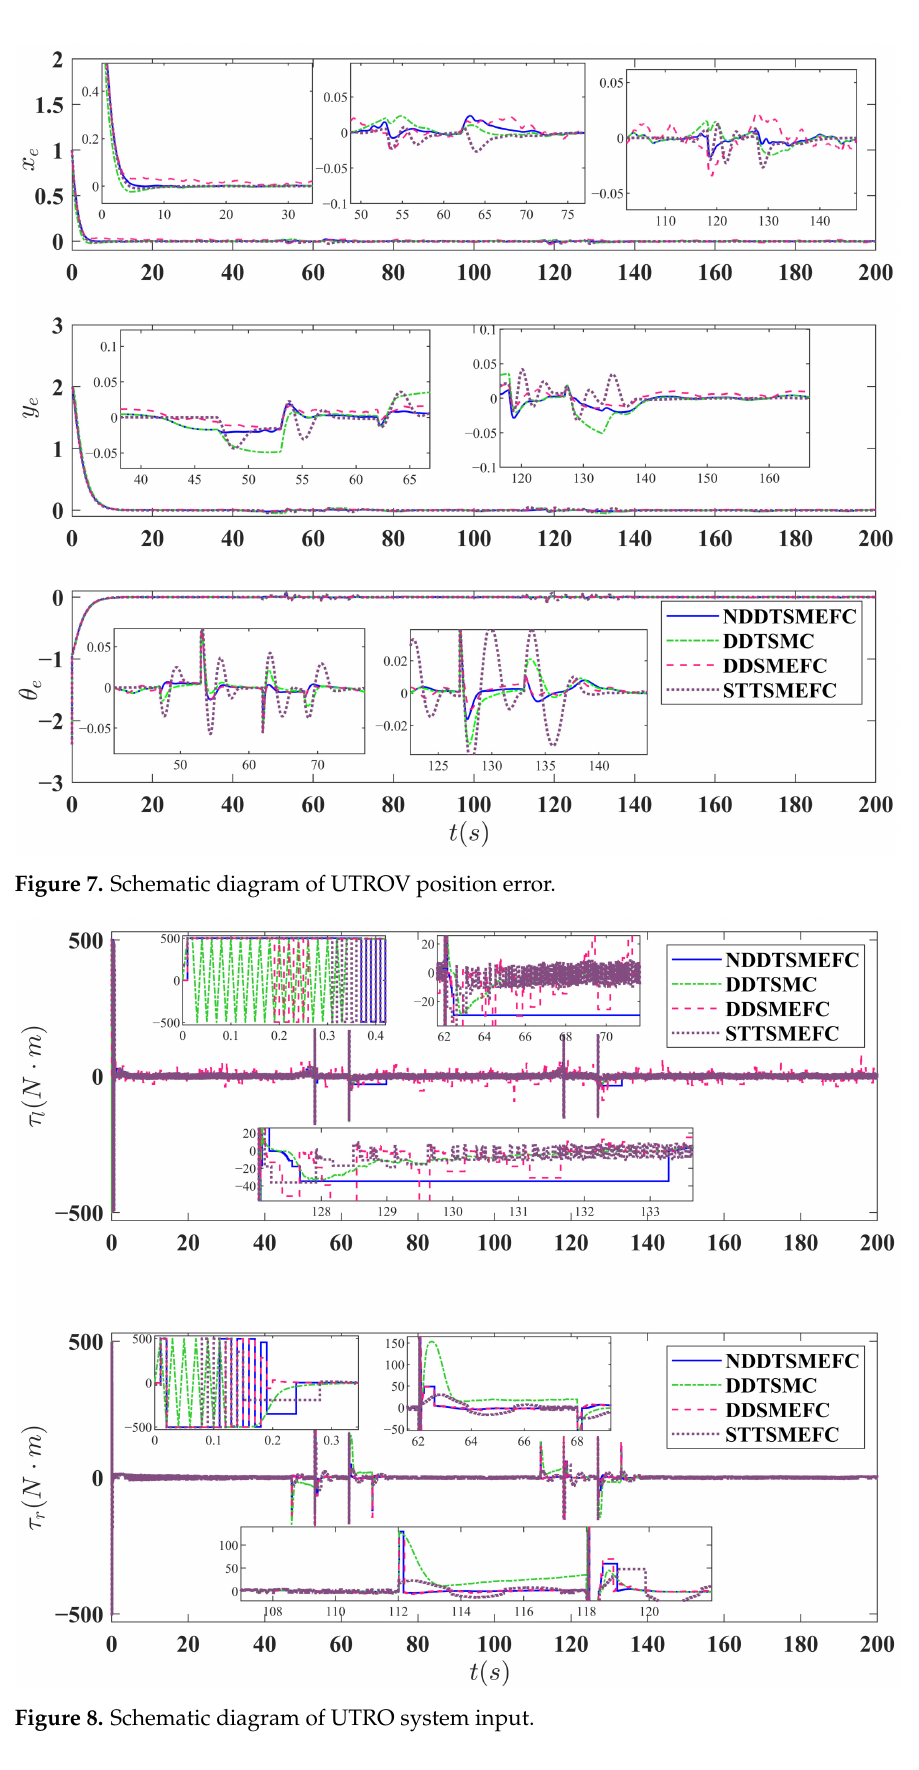
Figure 8. Schematic diagram of UTRO system input.